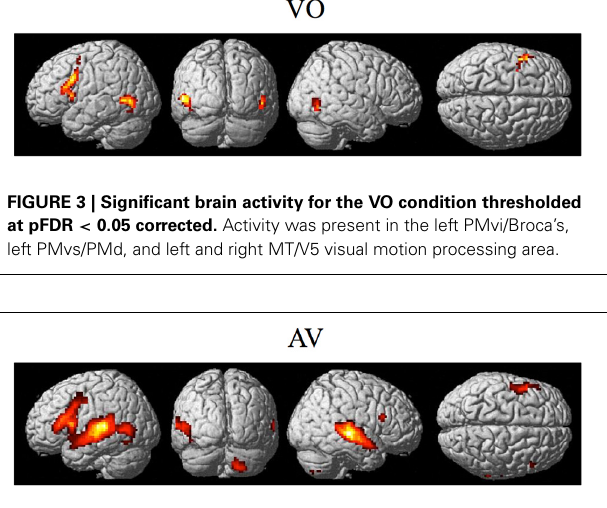
FIGURE 6 | Significant brain activity for the contrast that investigated the multisensory enhancement effect (AV10-A10)-(AV6-A6) thresholded at p < 0 . 001 uncorrected. Activity was present in left PMvi/Broca’s area, left pre- and post-central gyrus, left inferior parietal cortex and suprmarginal gyrus, the right occipital lobe, the right cerebellum lobule VIIb and IX, and the left and right brain stem. (A) Activity rendered on the surface of the left, back, right, and top of the brain. (B) Section through brain taken at MNI coordinate − 54, 3, 15 shows activity that was present in the PMvi and Broca’s region. (C) Section through brain taken at MNI coordinate 21, − 69, − 45 shows activity that was present in cerebellum lobule VIIb. L, left side of brain; R, right side of brain.